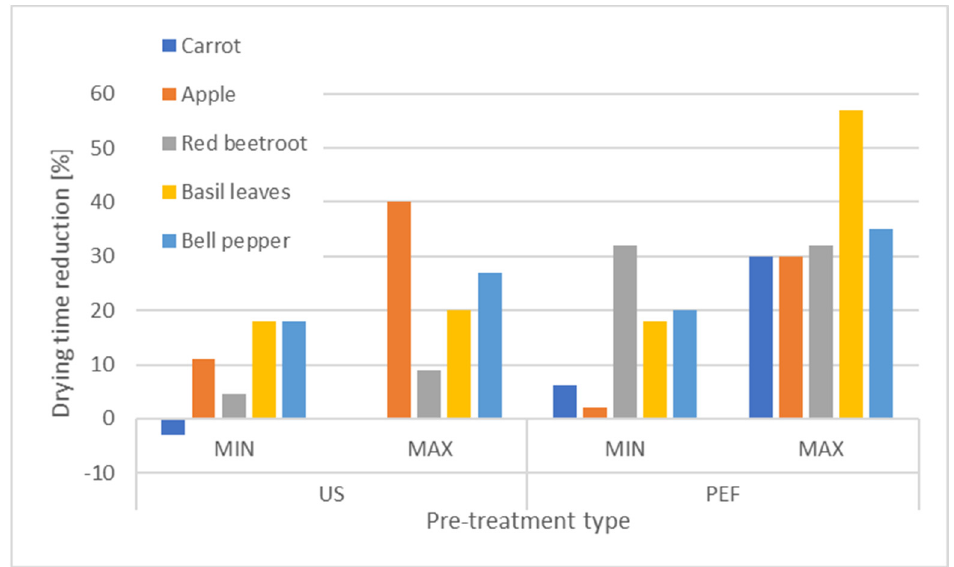
Figure 3. Minimum (MIN) and maximum (MAX) air drying time reductions for different food matrices as reported in the scientific literature for pulsed electric field (PEF) and ultrasound (US) pretreatment.